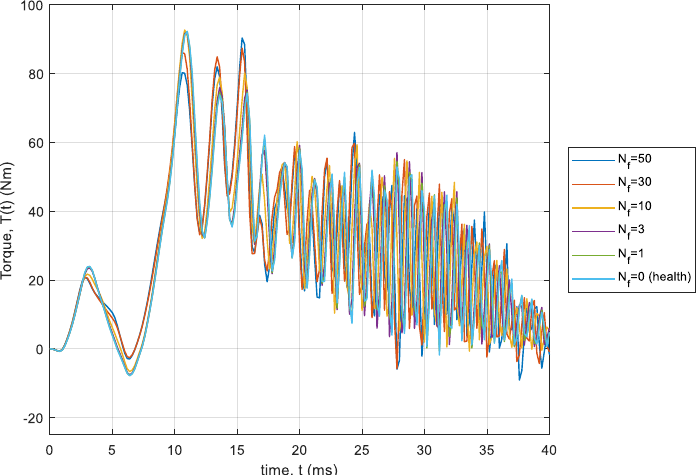
Figure 7. Torque waveforms during first period of start-up process at T L = 0 Nm.